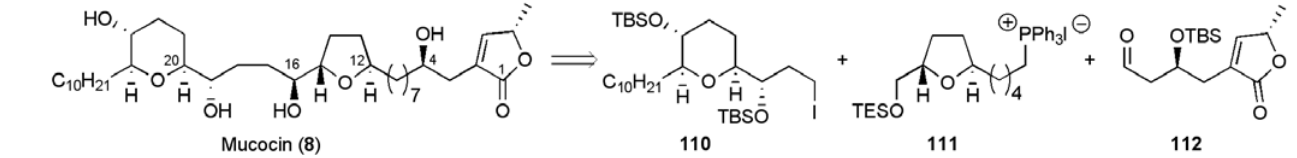
Figure 16. Koert’s synthetic approach to (–)-mucocin ( 8 )